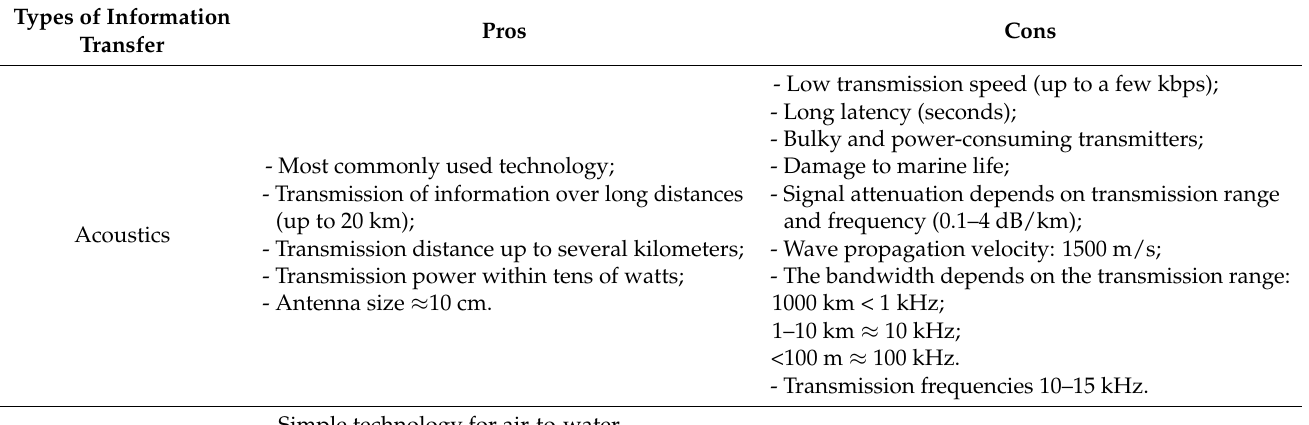
Table 4. Comparative characteristics of different wireless underwater communication